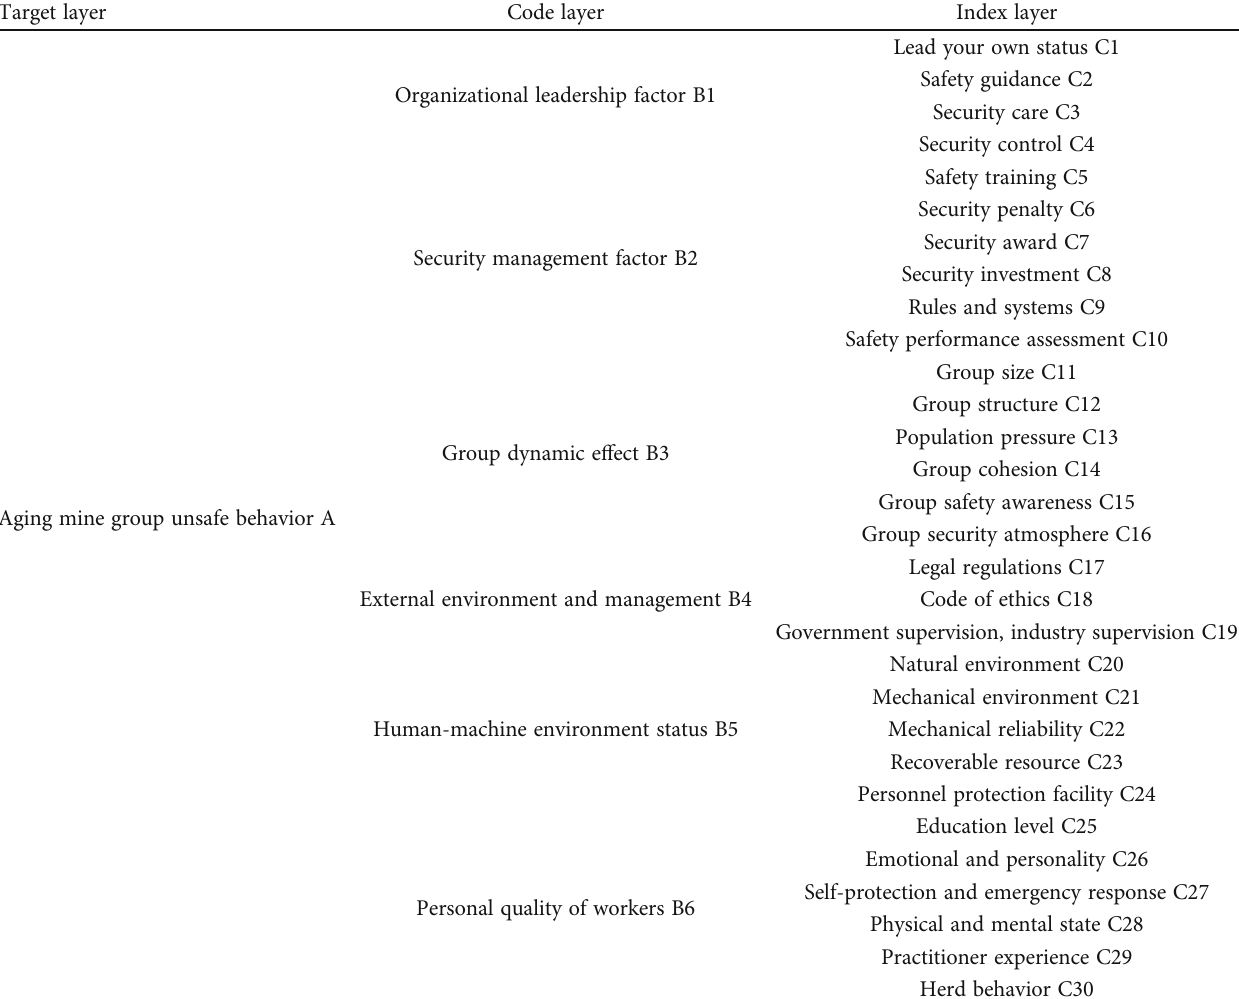
Figure 5: Fish thorn diagram of the unsafe behavior evaluation index system of the aging pit population. Table 1: Evaluation index system of unsafe behavior in aging pit